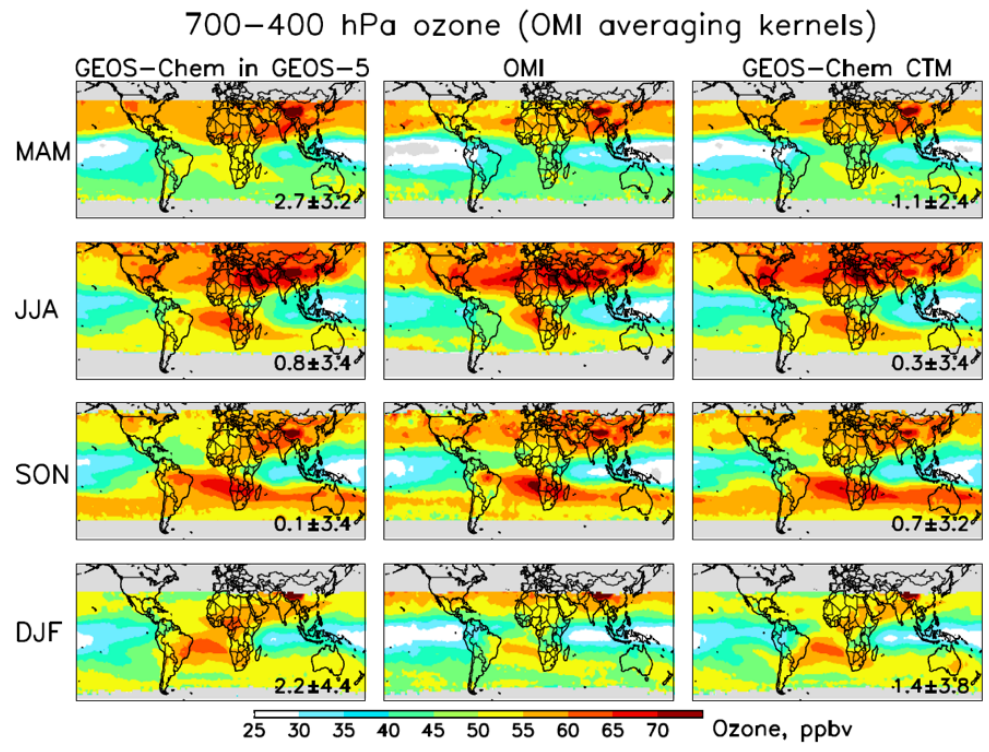
Figure 3. Middle tropospheric ozone distribution at 700–400hPa from the GEOS-5 Nature Run with GEOS-Chem chemistry (a) , Ozone Monitoring Instrument (OMI) satellite observations (b) , and the offline GEOS-Chem CTM (c) for four seasons covering July 2013– June 2014. The data are on a 2 ◦ × 2 . 5 ◦ grid. All data are smoothed by the OMI averaging kernels, using a single fixed a priori profile so that variability is solely driven by observations. The OMI observations have been further corrected for a global mean positive bias of 3.6ppbv (Hu et al., 2017). Both models are sampled along the OMI tracks. Numbers in the left and right columns are the mean model bias ± standard deviation. Gray shading indicates regions where OMI data are unreliable and not used (poleward of 45 ◦ in winter–spring and poleward of 60 ◦ year round; see Hu et al.,